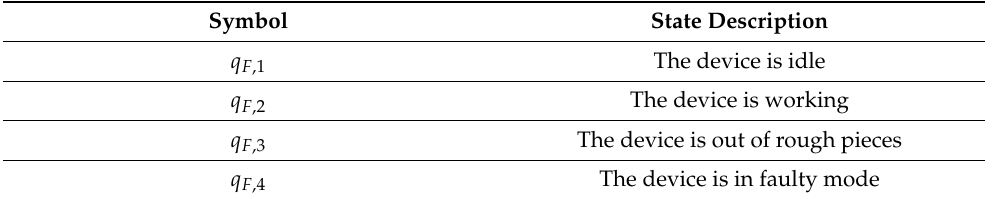
Table 11. States of the feeding device.